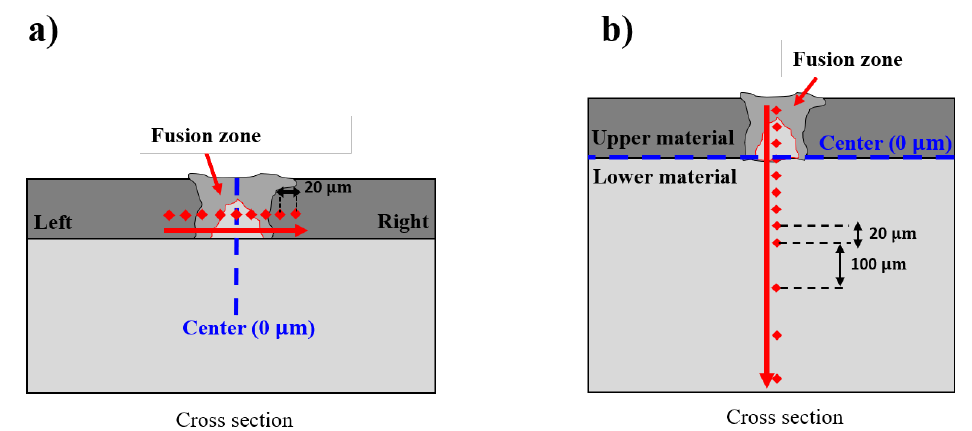
Figure 10. Schematics of the hardness measurement: ( a ) Horizontal direction, ( b ) Vertical direction.